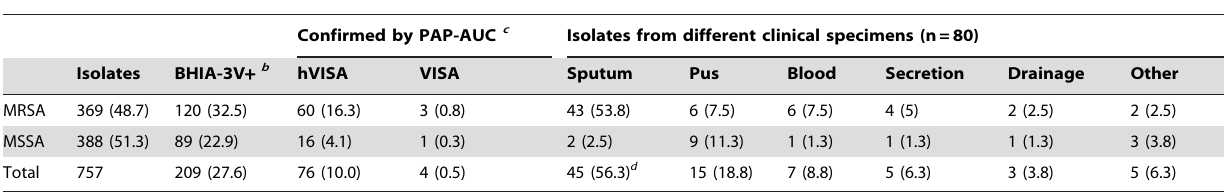
Confirmed by PAP-AUC